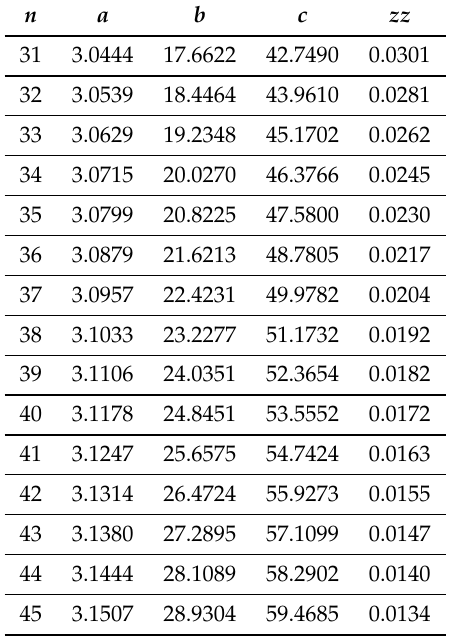
Table 2. Ideal point method (confidence level is